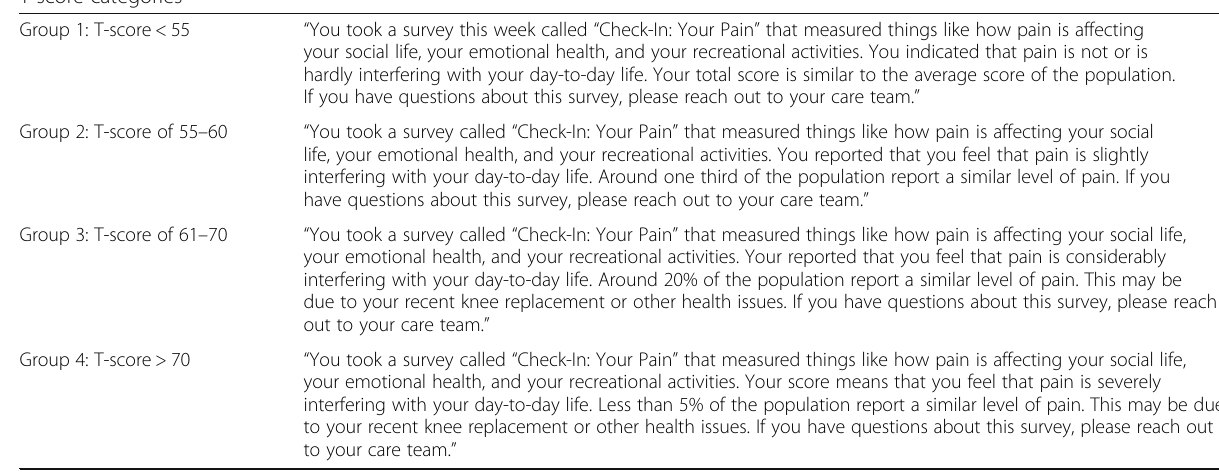
Table 2 Preliminary version of the text-based PRO feedback report for the health domain of Pain Interference according to grouped T-score